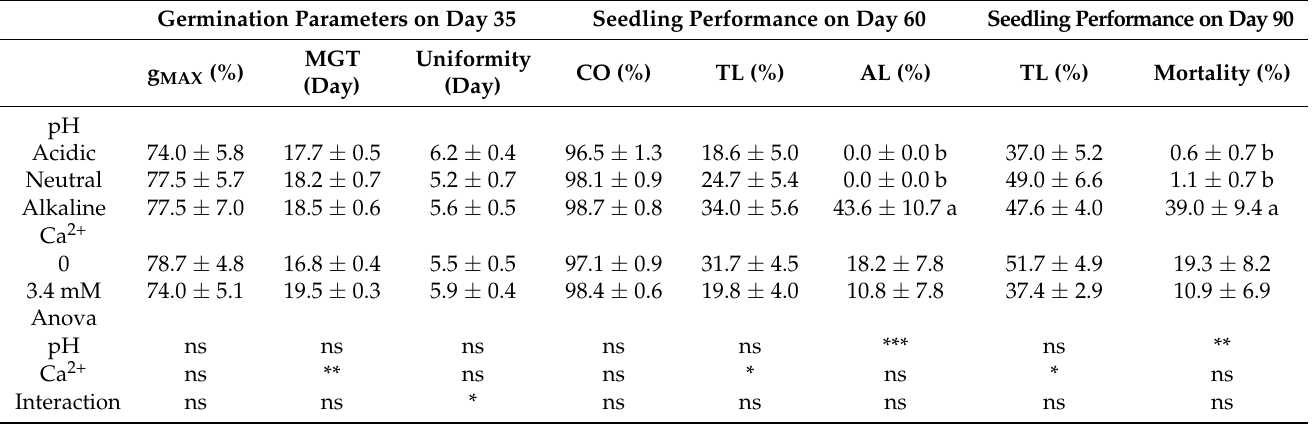
Table 3. Effects of pH and additional 3.4 mM Ca 2+ on maximum germination (g MAX ), mean